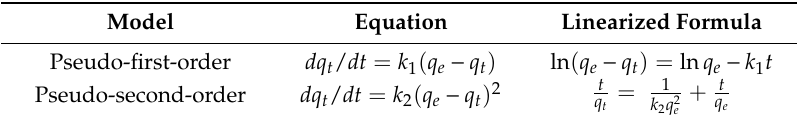
Table 3. Kinetic equations of biosorption.